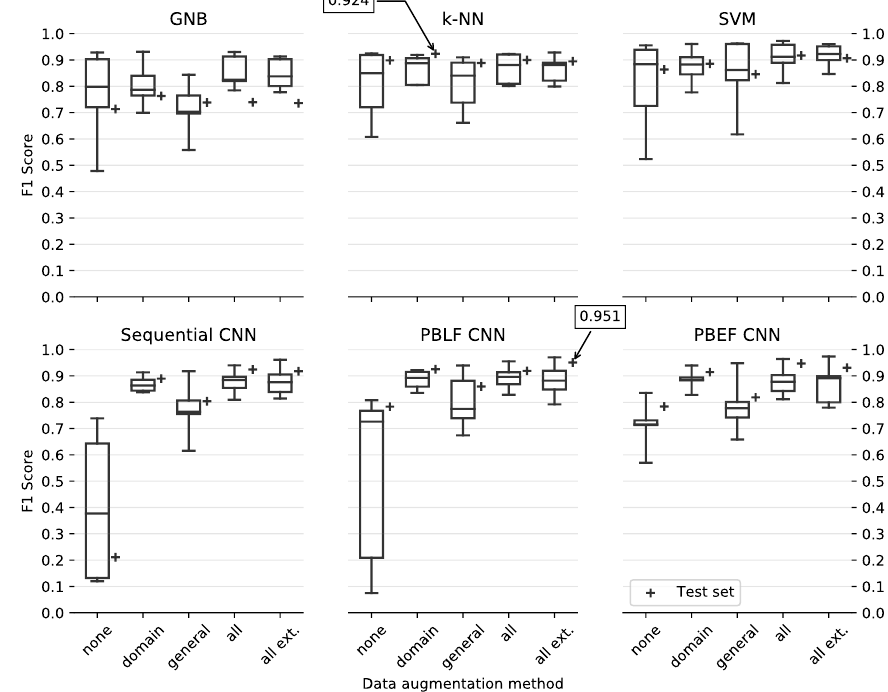
Figure 10. Box plot for the person dependent evaluation is shown on the left side, conventional classifiers in the upper row and CNN models below. The different data augmentation variants are on the x-axis for each model. The + indicates the performance on the test